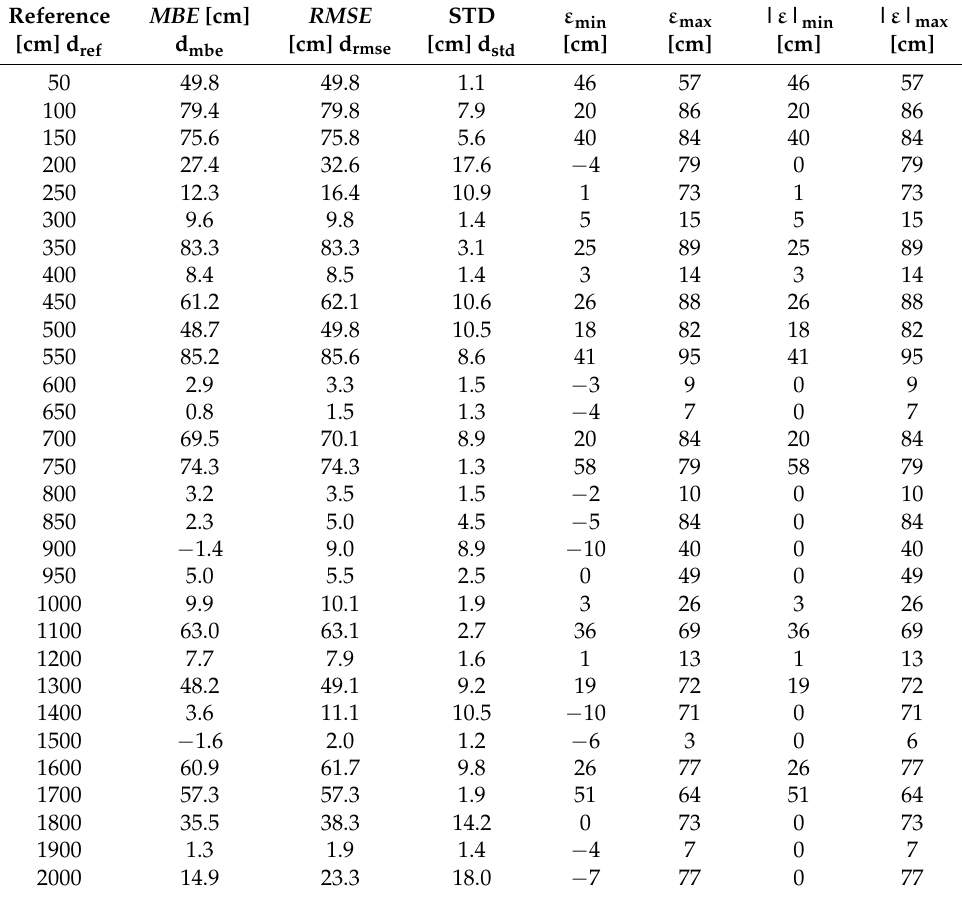
Table 5. Statistical measures of accuracy (distance error) under NLOS